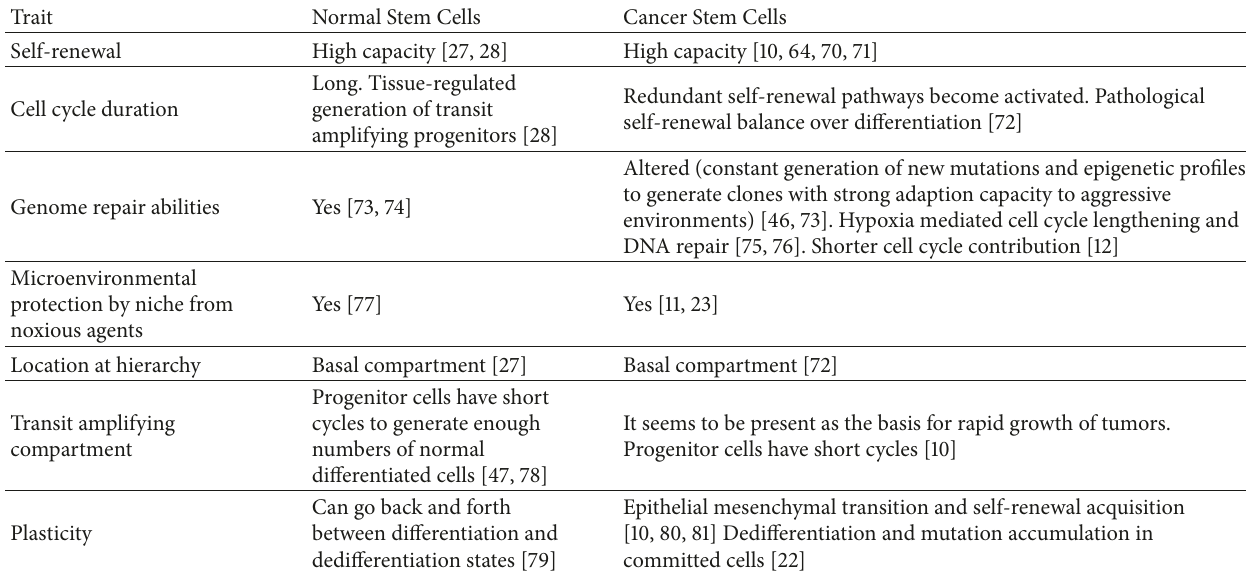
Table 1: Comparison of traits of normal Stem Cells and Cancer Stem Cell